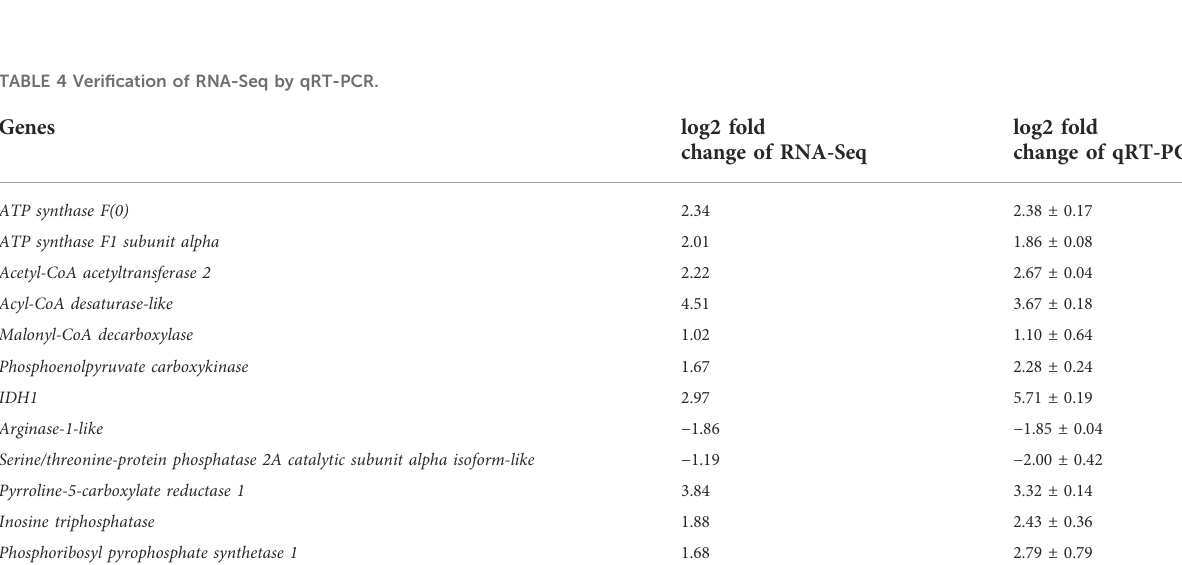
TABLE 4 Veri fi cation of RNA-Seq by